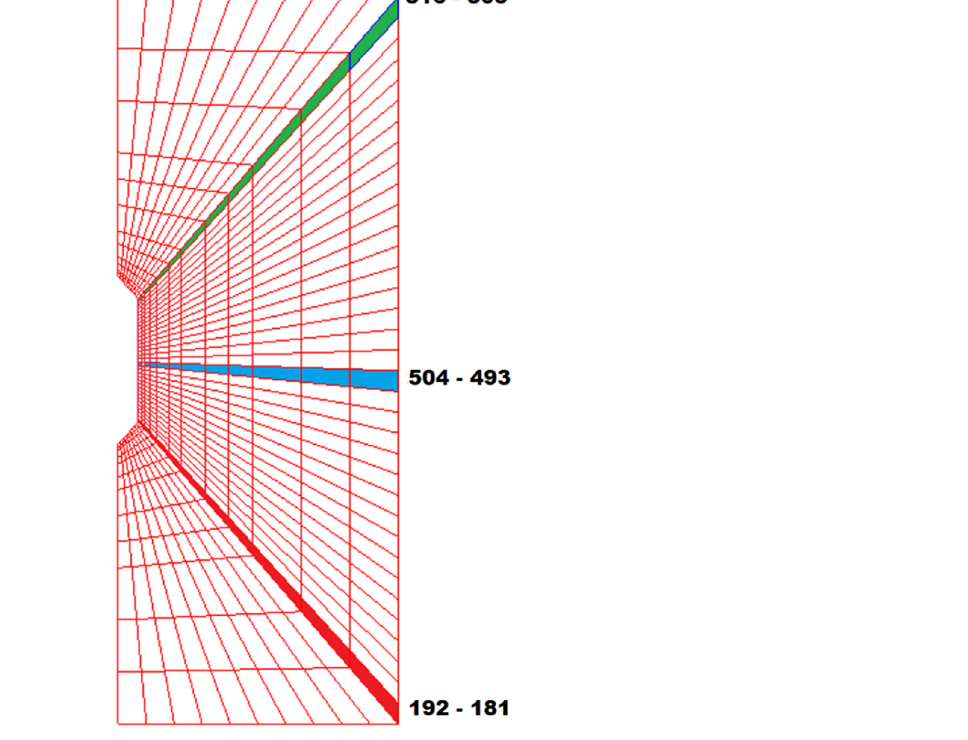
Figure 5. Cavern mesh adopted for numerical calculations with marked elements on the ceiling, wall and bottom, i.e., where the effort of the rock mass was assessed.